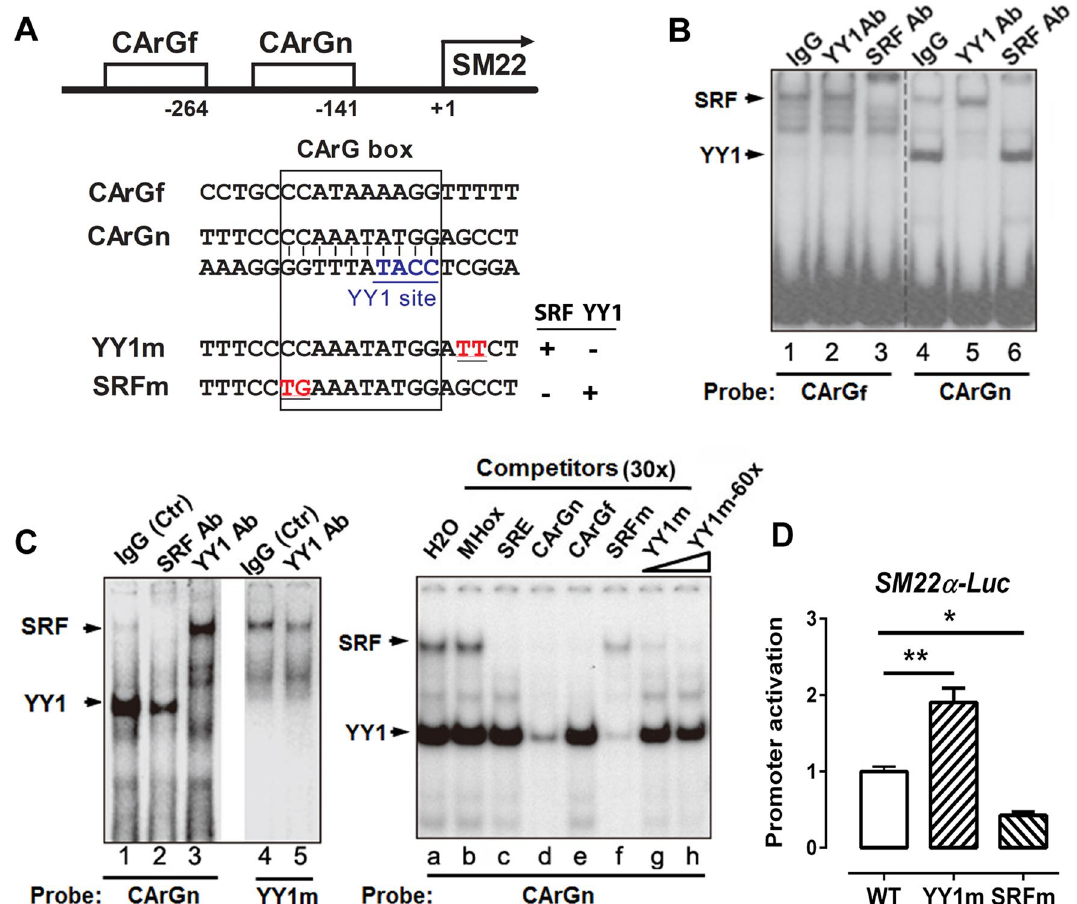
Figure 3. Characterization of YY1 binding to the proximal CArG box (CArGn) of the SM22α promoter in VSMCs. ( A ) The diagram to illustrate the location of CArGfar (CArGf) and CArGnear (CArGn) boxes at about 264-bp and 141-bp upstream of the transcription initiation site in the SM22α promoter, respectively. The CArGn box contains an overlapping CArG box and YY1 binding site. Mutations were generated in YY1m and SRFm oligo to selectively abolish the binding of YY1 or SRF but retain the binding of SRF or YY1 to the proximal CArG box, respectively. The mutated nucleotides are underlined and coded in red. ( B ) Gel shift assays showed the binding of SRF and YY1 to the CArG box using the nuclear extract from PAC1 cells and the indicated 32 P labelled CArGn or CArGf oligo as the probe. The dashed line indicates noncontiguous lanes merged from the same gel. ( C ) YY1 binding site mutation selectively abolished the binding of YY1, not SRF to the YY1 mutant oligo (YY1m) (left panel). Mutation at the SRF binding site (SRFm) competed the binding of YY1, not SRF to the CArGn probe (right panel). MHox 30 and SRE 31 oligos served as the negative and positive control for SRF binding, respectively. ( D ) Luciferase reporters driving by the WT, YY1 binding site mutant (YY1m) or SRF binding site mutant (SRFm) of the SM22α promoter were transfected into PAC1 cells. 48 h post